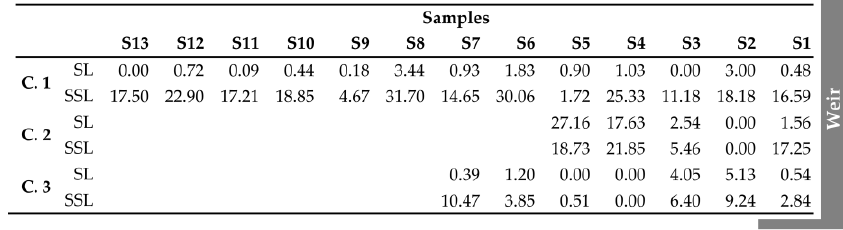
Figure 4. Percentage of grain sizes less than 2 mm for the surface layer samples (SL) and subsurface layer samples